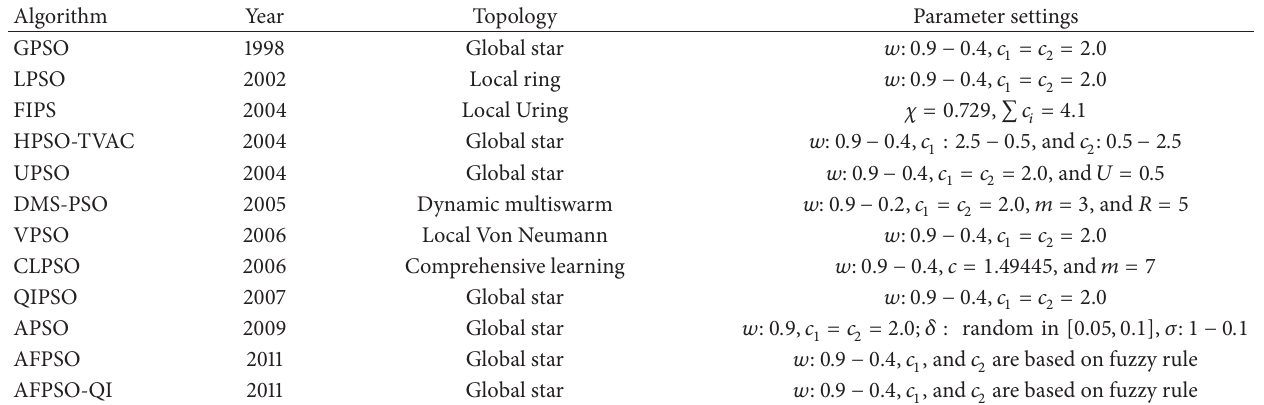
Table 5: Some well-known PSOs algorithms in the